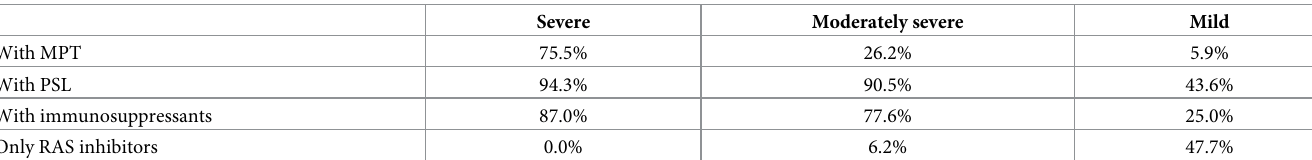
Table 4. Despite large variation in the treatment protocols for the three severity groups (for